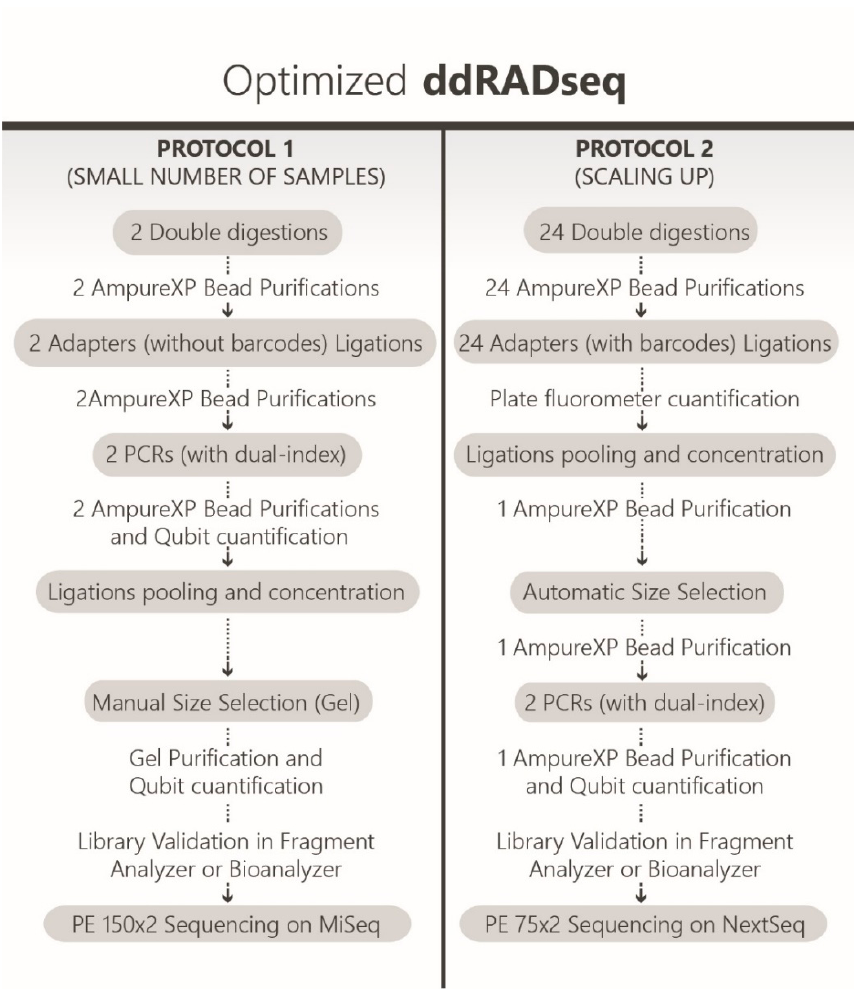
Figure 1. Workflow of the two optimized ddRADseq protocols.